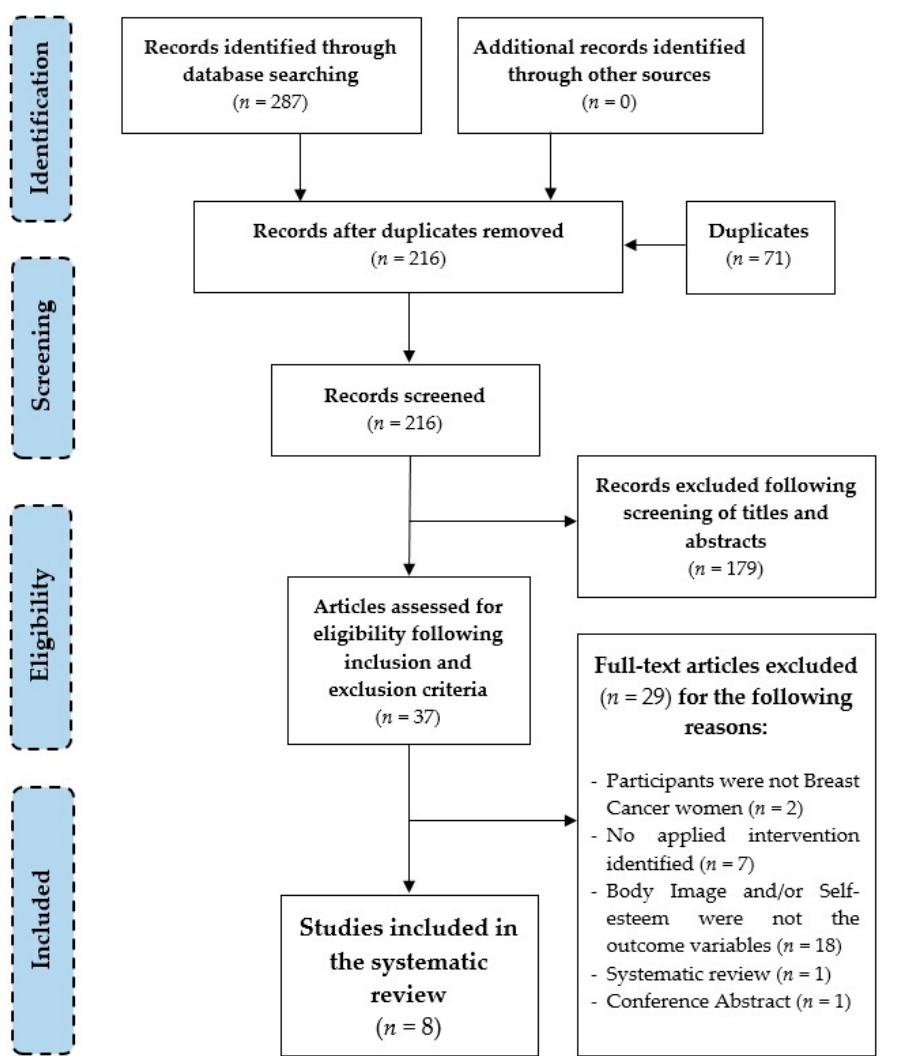
Figure 1. Flow diagram of the selection process of the studies.